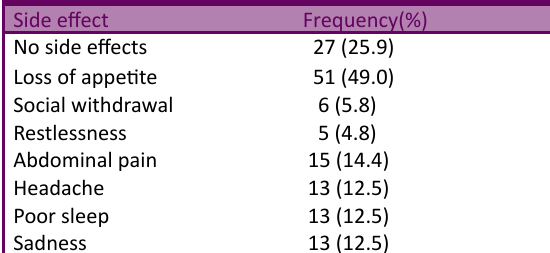
Table 1 – Frequency distribution of age groups